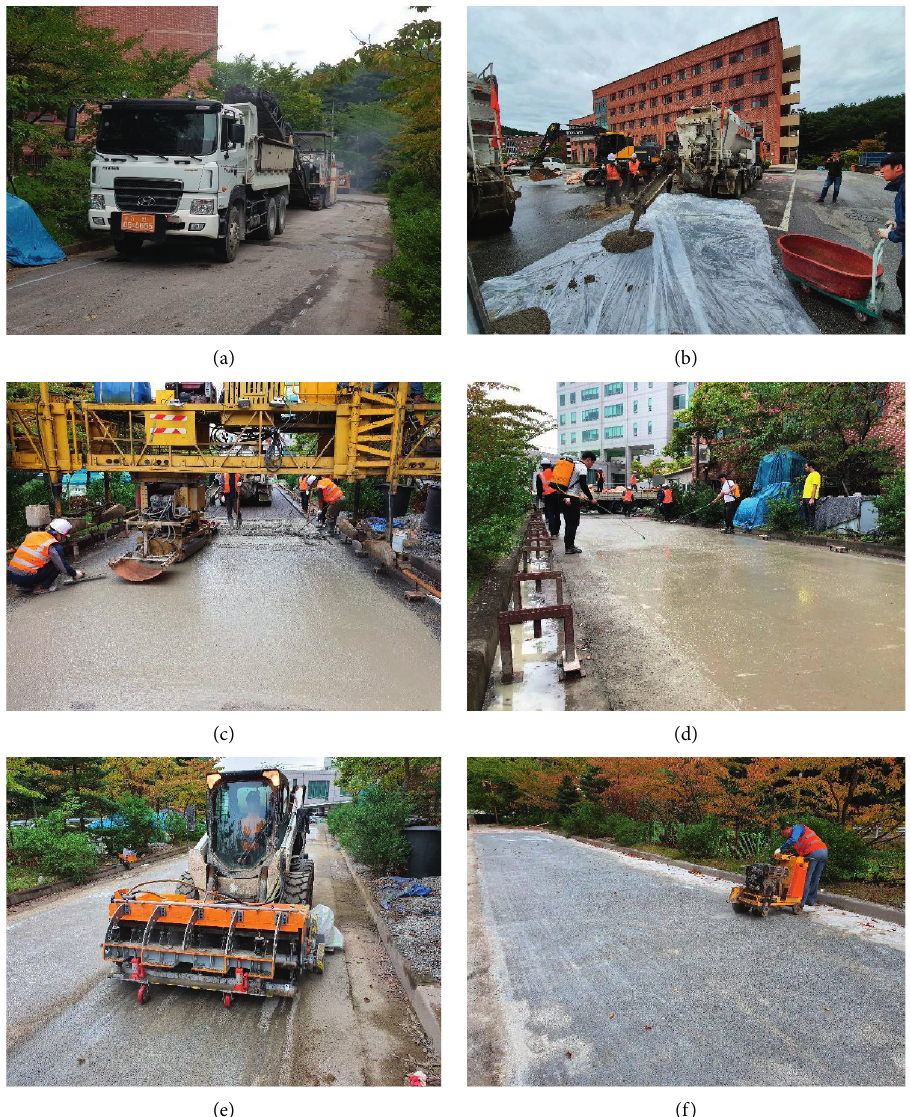
Figure 3: Mock-up construction process of exposed aggregate concrete overlay: (a) substrate preparation; (b) mobile mixer; (c) deck finisher; (d) spraying retardant; (e) exposing aggregate; (f) joint saw-cutting.